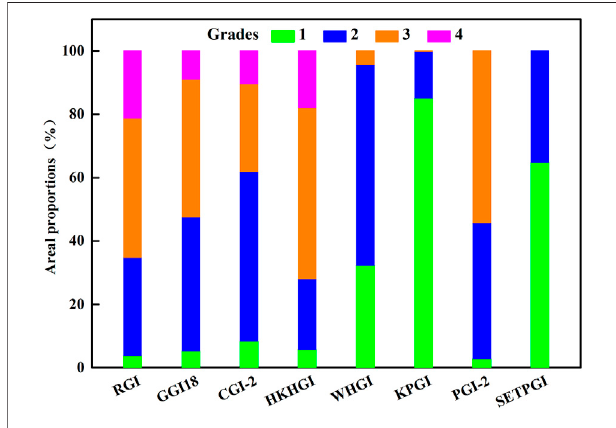
TABLE 5 | Comprehensive quality-grading results of the eight glacier inventories for the nine regions of different product overlaps and the areal percentages of grades for each inventory. See Figure 1 for the regions.